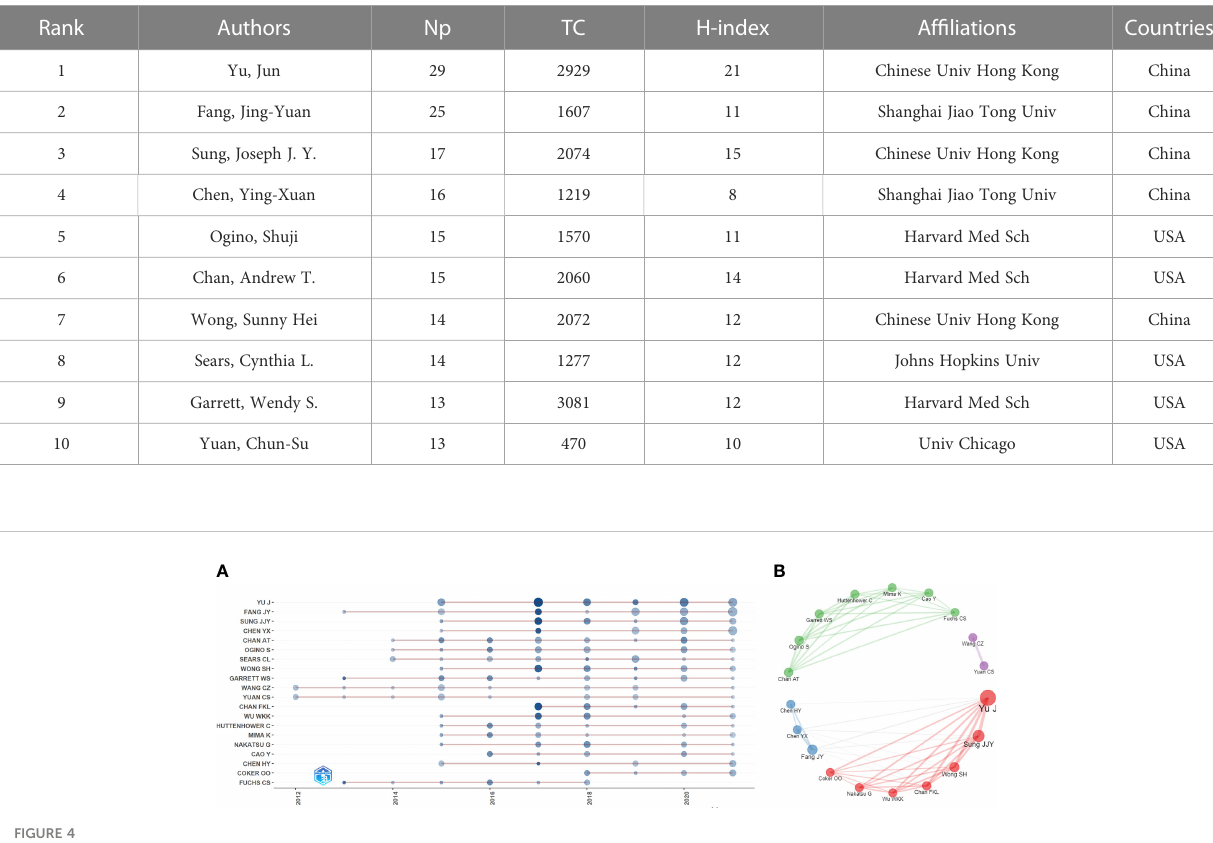
FIGURE 4 (A) Annual output of the top 20 productive authors over time in IM/CRC (sizes of the circle signify scienti fi c output, and the larger the circle, the more scienti fi c output; color depth of the circle indicates the annual citations, and the darker the color, the more citations). (B) Co-authorship network of the top 20 productive authors (remove isolated nodes) in IM/CRC (each node represents an author, and its size represents scienti fi c output, each color represents a cooperative group, each line represents a coordination relation and its thickness represents cooperation intensity).